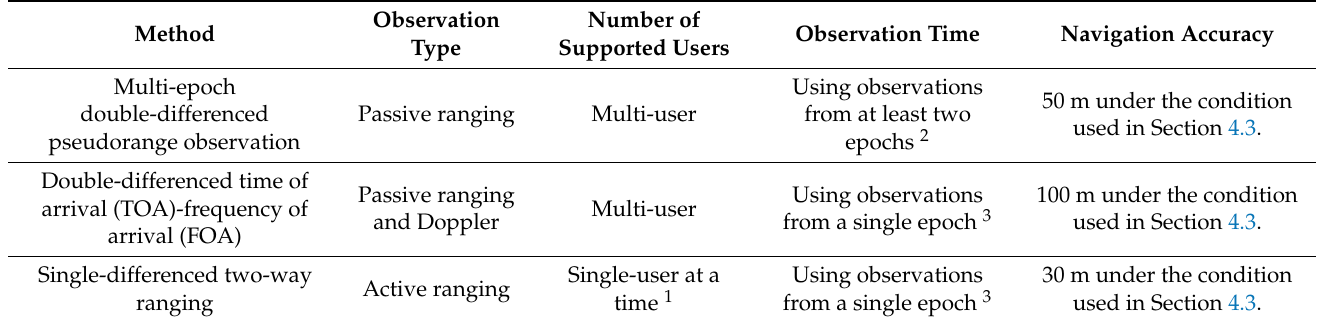
Table 1. Benchmark of dual-satellite lunar navigation